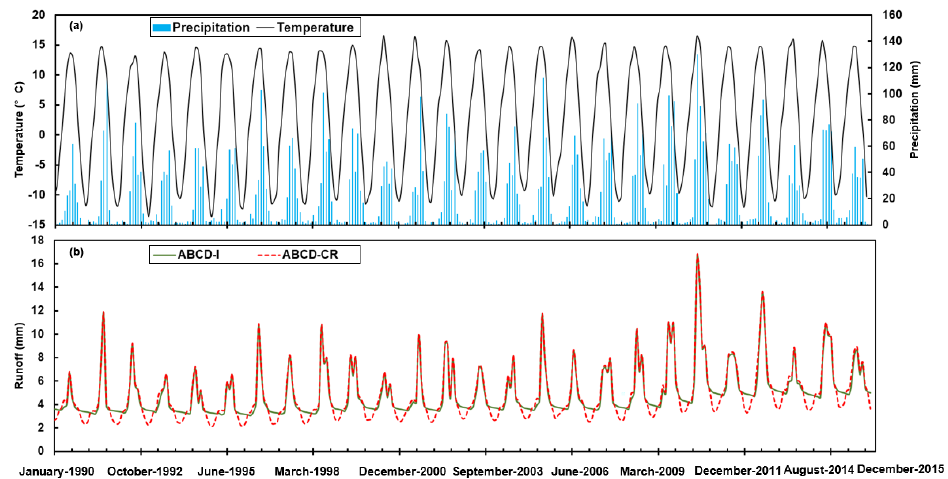
Figure 9. Restoring results of the monthly runoff in the study catchment ( b ) with meteorological data in the period 1990–2015 ( a ).